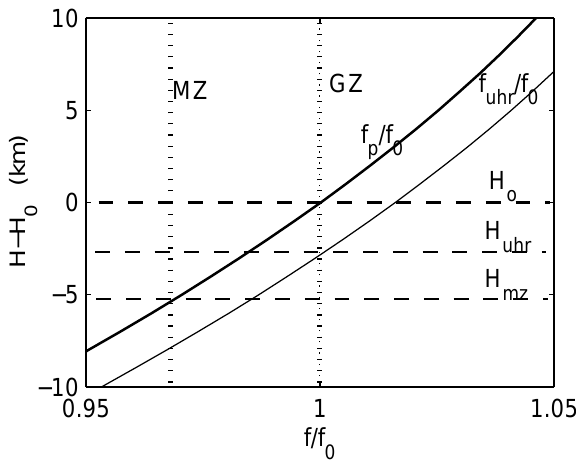
Fig. 1. Schematic of regions near ordinary-mode reflection for ver- tical and magnetic field-aligned heater pointings. Solid lines des- ignate the plasma (heavy line) and upper hybrid resonance (thin) frequencies; vertical dotted lines show the cutoff frequencies at GZ and MZ, respectively; horizontal dashed lines indicate the heights of reflection at GZ, the upper hybrid resonance, and MZ.